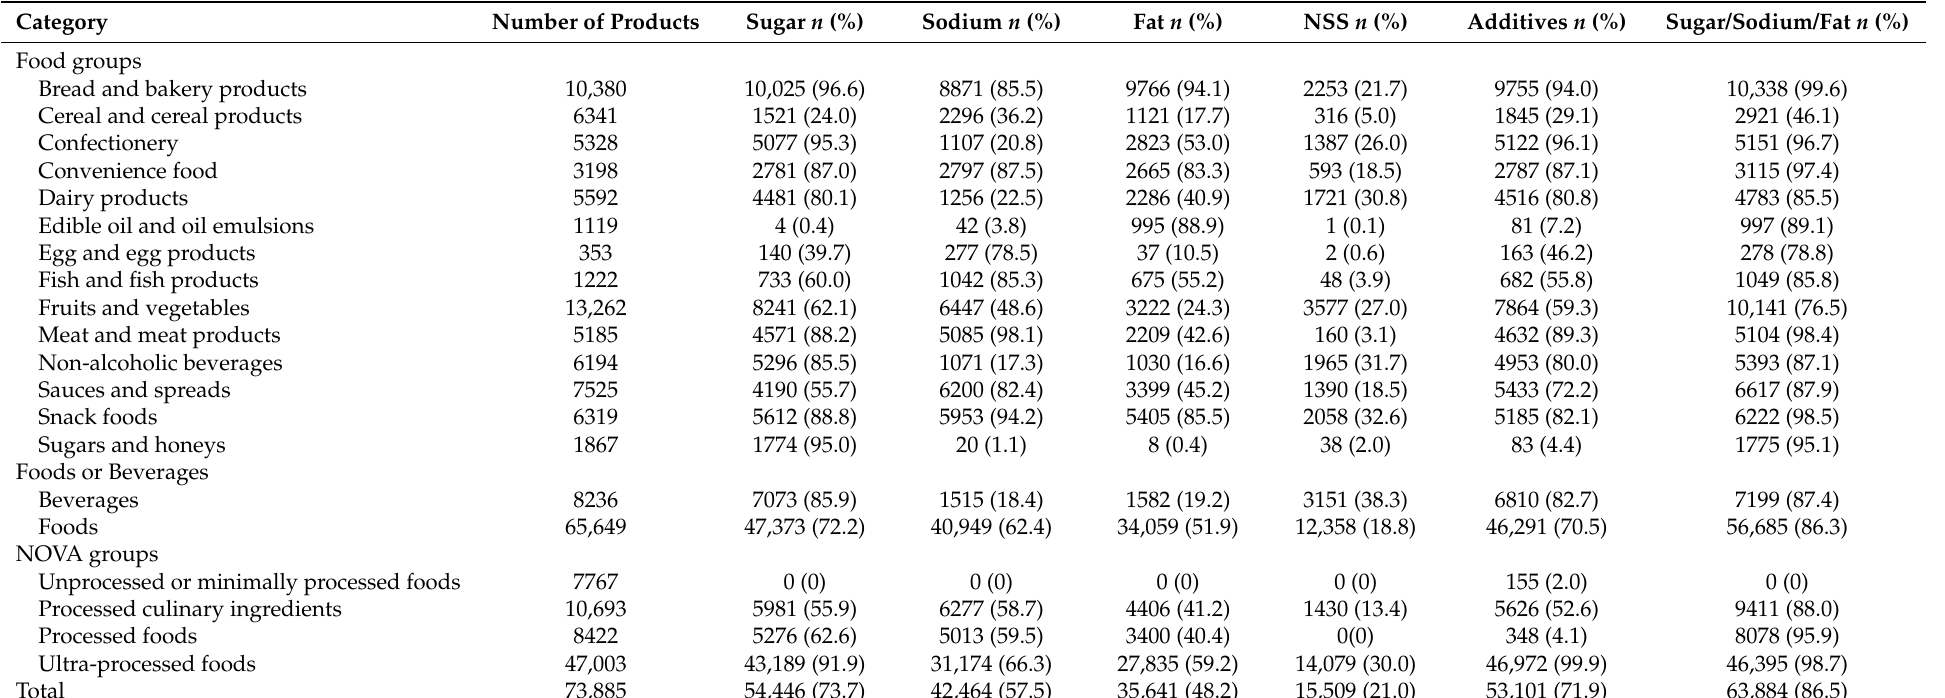
Table 1. Proportion of food products with sugar, sodium, fat, and food additives in